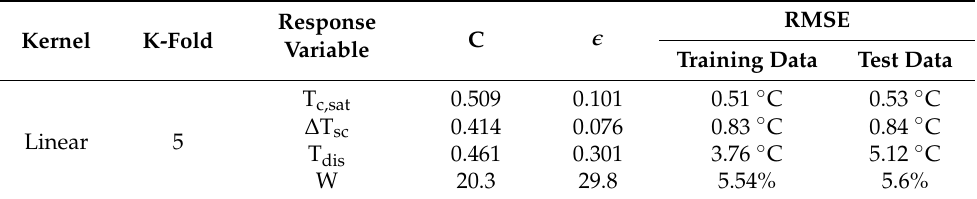
Table 4. Optimized parameters of support vector machine (SVM) in grid